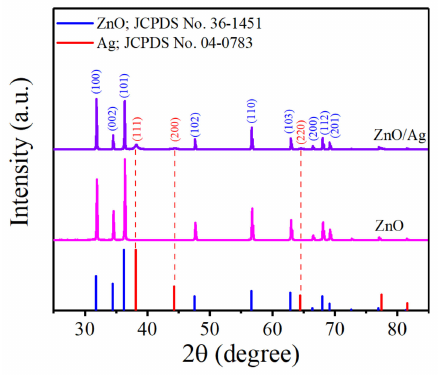
Figure 2. XRD patterns of ZnO and